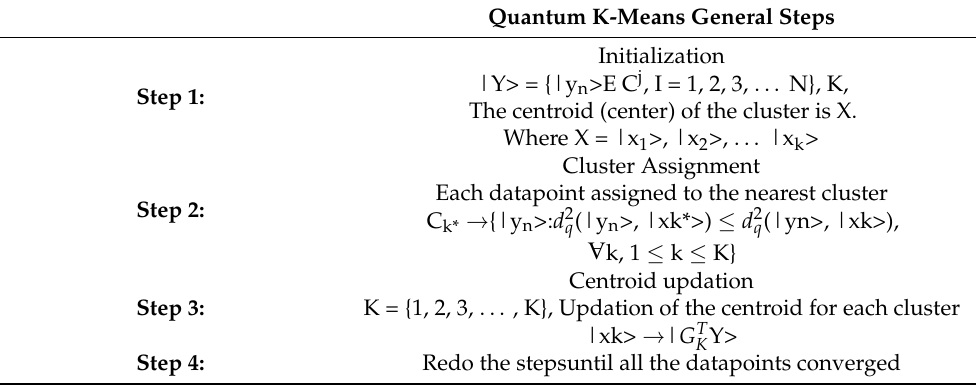
Table 3. The steps shows the general stages of the quantum k-means algorithm